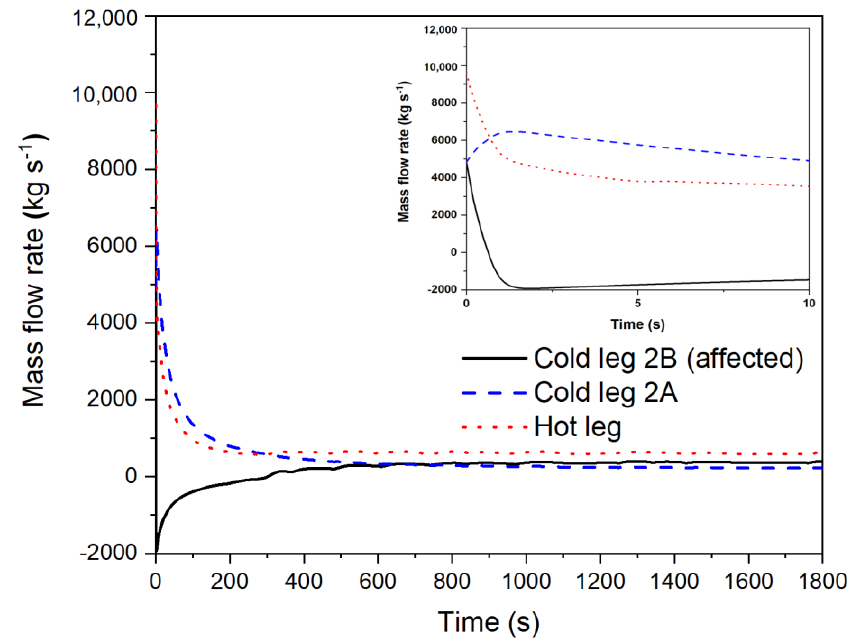
Figure 3. Mass flow rate in each loop.